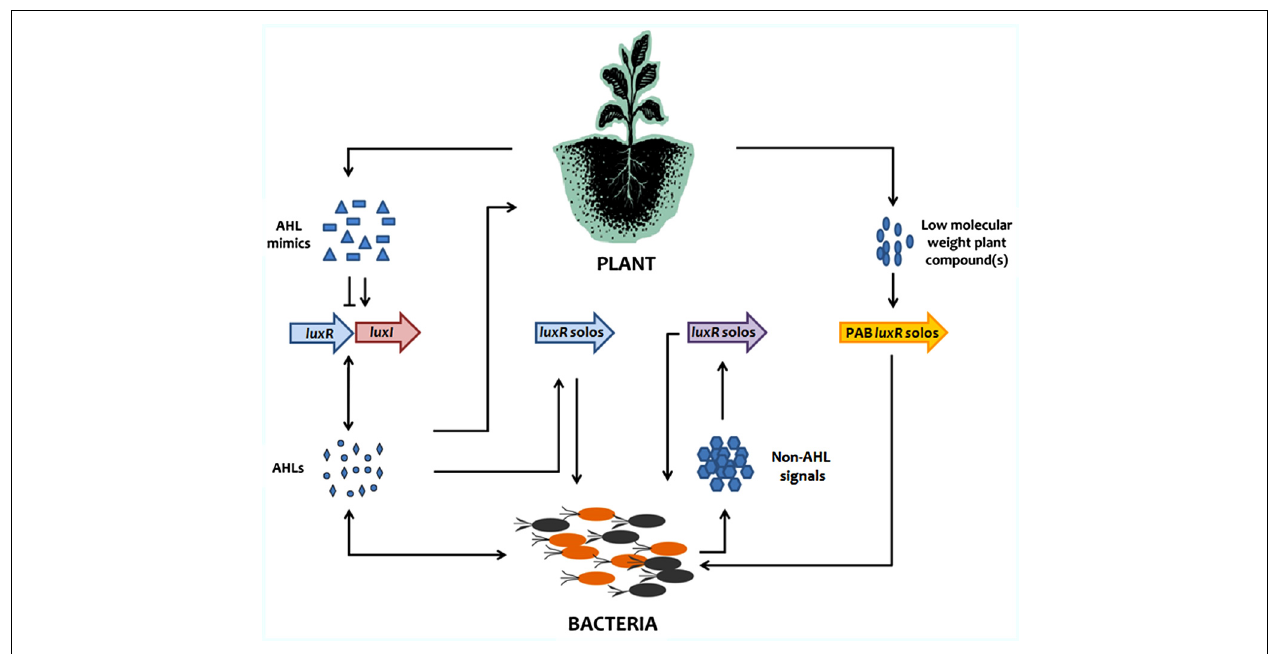
FIGURE 1 | Summary of current mode of action ofAHL QS and of LuxR solos in signaling between plants and